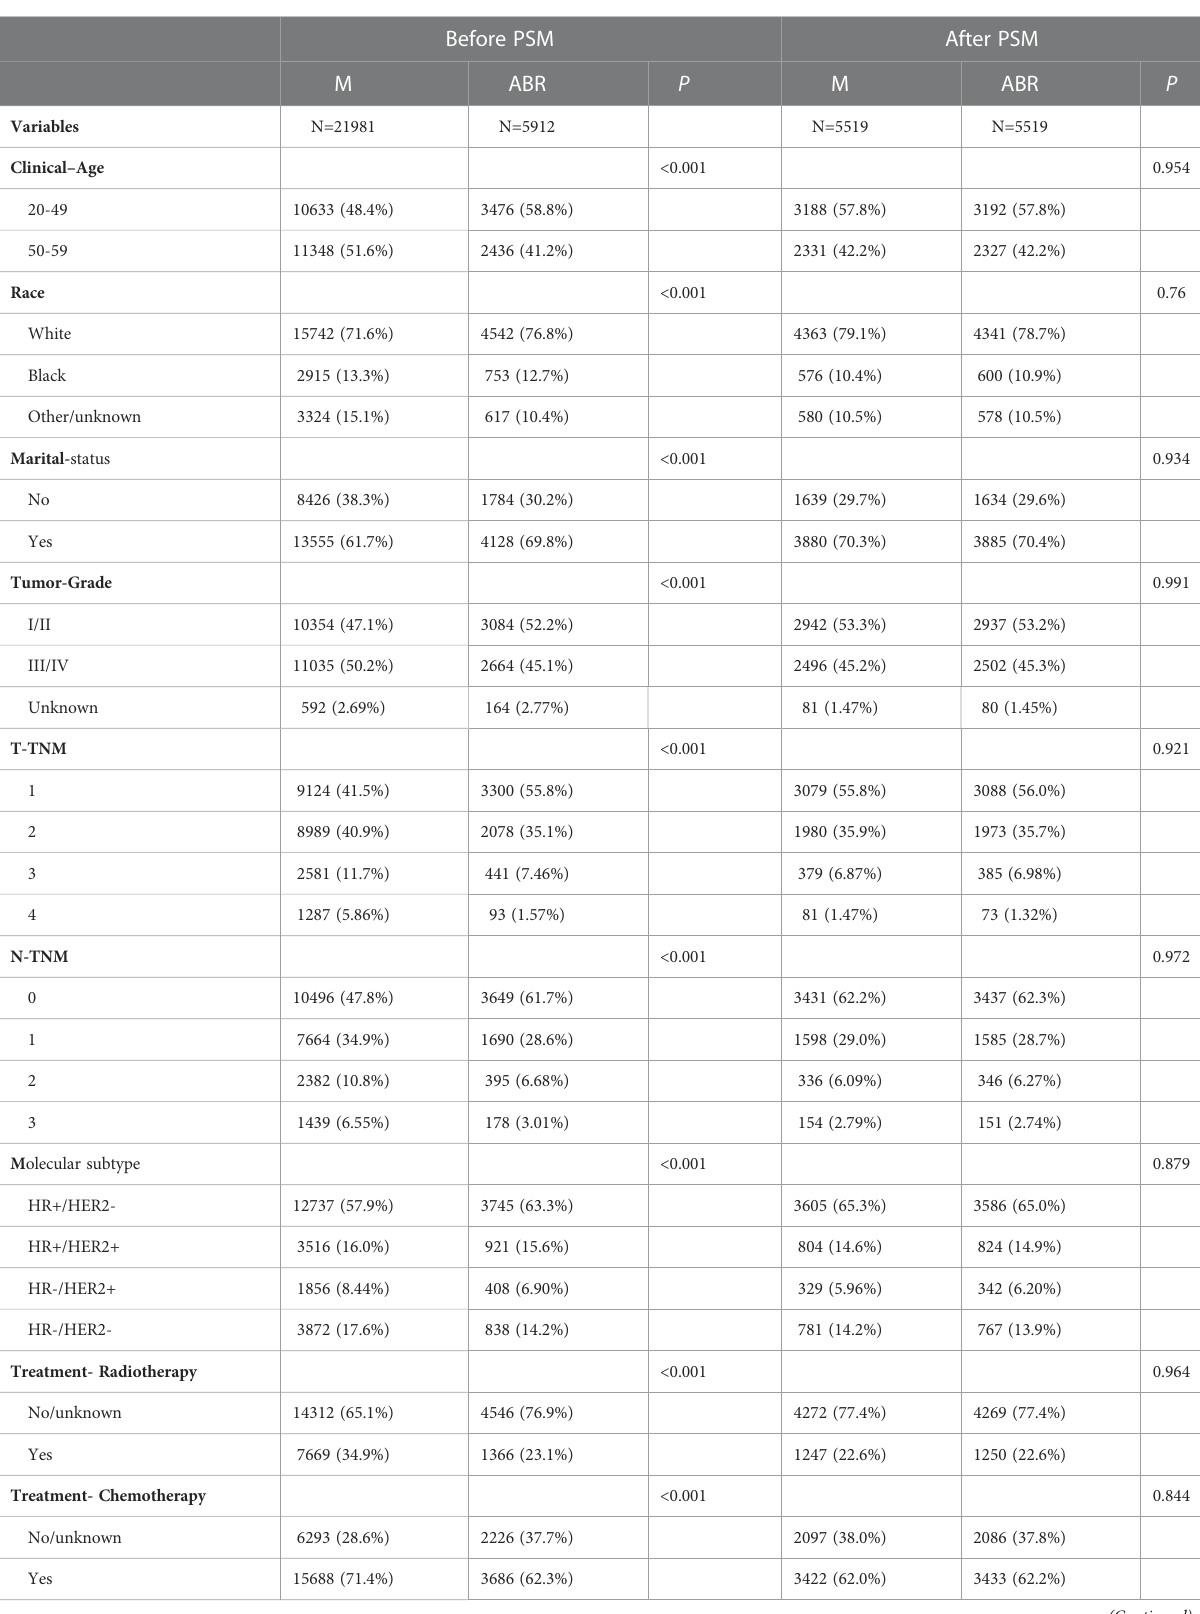
TABLE 1 The clinicopathological characteristics of BC patients before and after